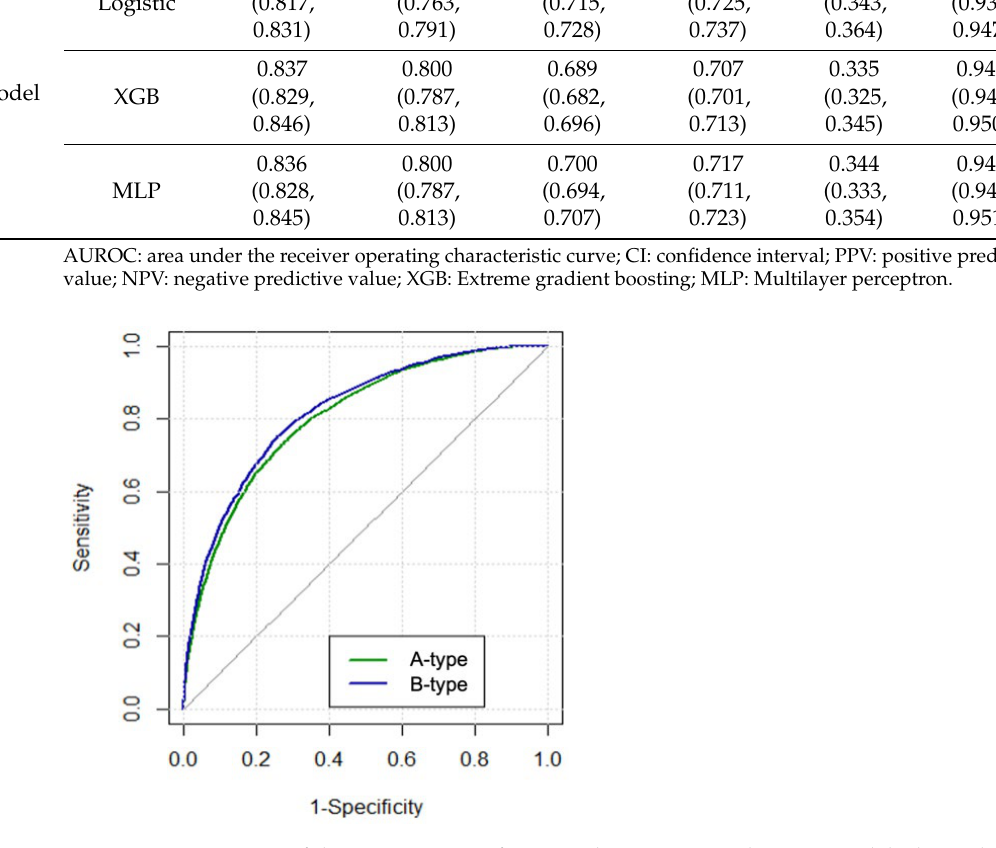
Figure 3. Comparison of discriminative performance between A- and B-type models derived using the conventional logistic regression method.